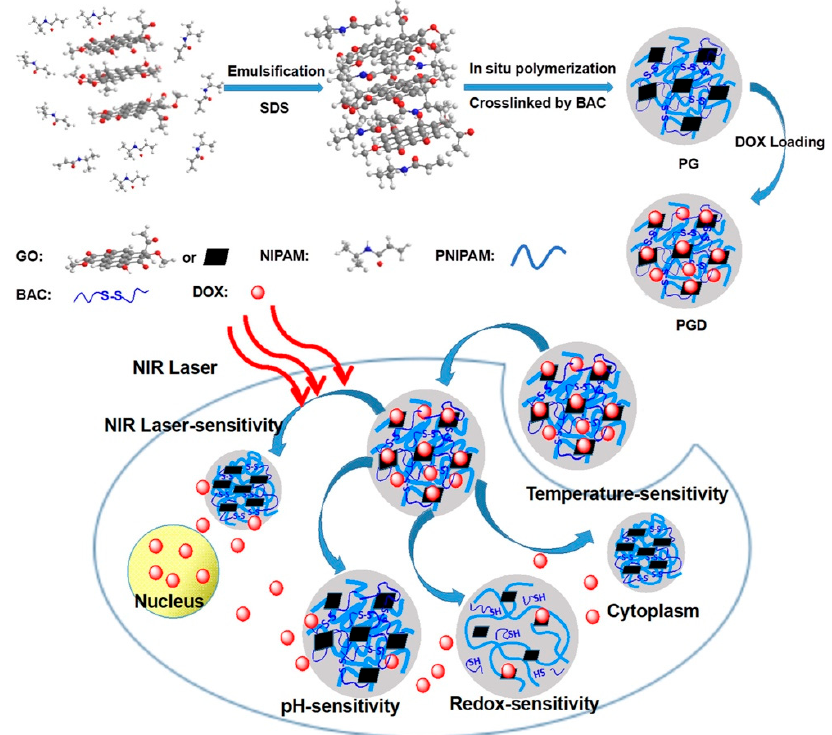
Figure 10. The schematic illustration of in situ polymerization of GO-hybridized nanogels (PG) and the DOX-loaded PG (PGD) with NIR laser-triggered and redox-responsive drug release, which exhibited the potentiality for combinational photothermal-chemotherapy. Adapted with permission from (ACS Appl. Bio Mater. 2018, 2, 330 − 338). Copyright (2018) American Chemical Society.